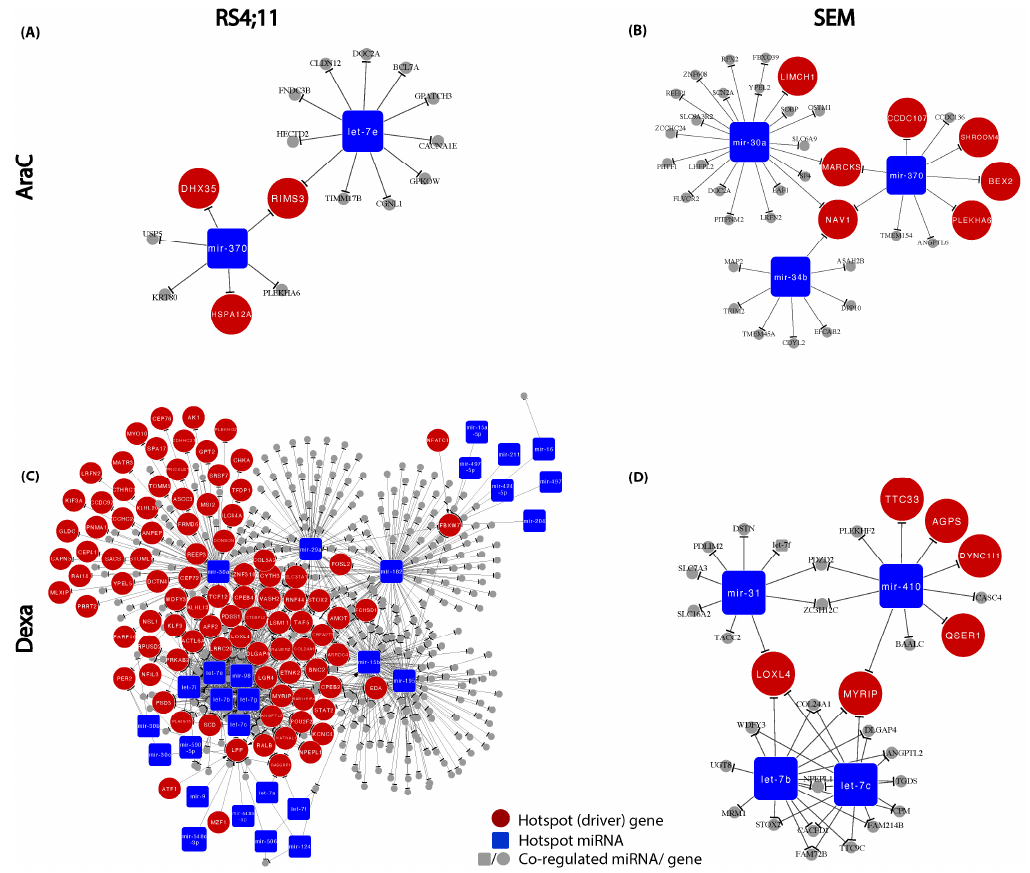
Figure 5. GRNs in response to AraC and Dexa in RS4;11 and SEM. Large red nodes represent the hotspot (driver) genes, blue squares indicate hotspot miRNAs and grey nodes denote the co-regulated miRNAs/genes for ( A ) AraC in RS4;11, ( B ) AraC in SEM, ( C ) Dexa in RS4;11 and ( D ) Dexa in SEM.